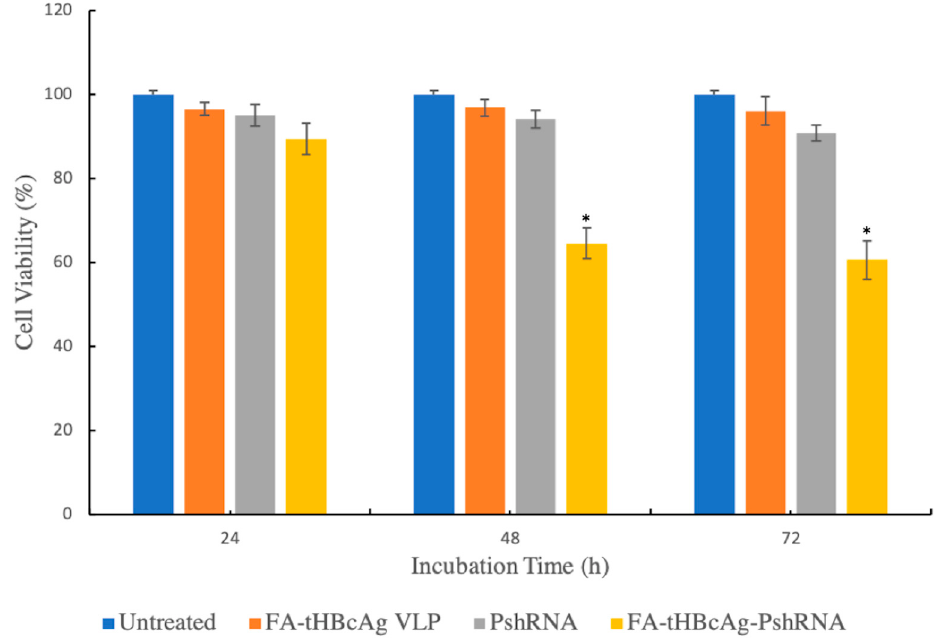
Figure 7. The 3 ‐ (4, 5 ‐ dimethylthiazol ‐ 2 ‐ yl) ‐ 2, 5 ‐ diphenyltetrazolium bromide (MTT) assay of HeLa cells transfected with tHBcAg VLP encapsidating shRNA plasmid and conjugated with FA. Viable HeLa cells treated with FA ‐ tHBcAg ‐ PshRNA VLP (PshRNA packaged with truncated hepatitis B core antigen and conjugated with folic acid) reduced slightly at 24 h (89.46 ± 3.7%), and reduced significantly at 48 h (64.52 ± 3.6%; p < 0.005) and 72 h (60.63 ± 4.5%; p < 0.005) post ‐ transfection. Viable cells treated with FA ‐ tHBcAg (truncated hepatitis B core antigen conjugated with folic acid) and PshRNA (plasmid synthesizing short hairpin RNA) showed no significant reduction at 24, 48 and 72 h post ‐ transfection. * shows significant difference ( p < 0.01) compared to the groups treated with FA ‐ tHBcAg VLP and PshRNA.